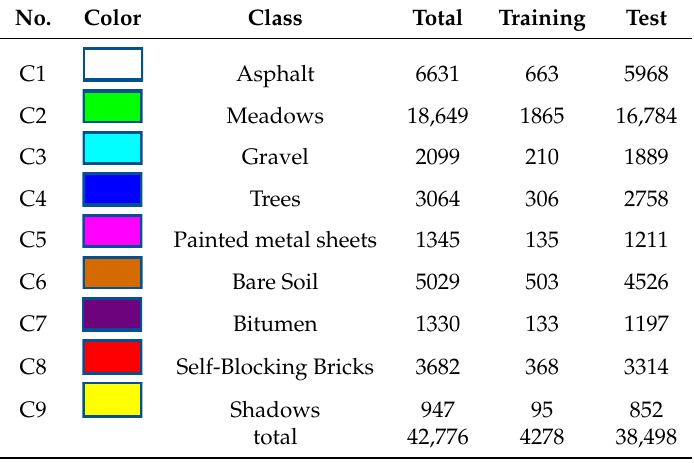
Table 3. Pavia University data for various training samples and test samples.